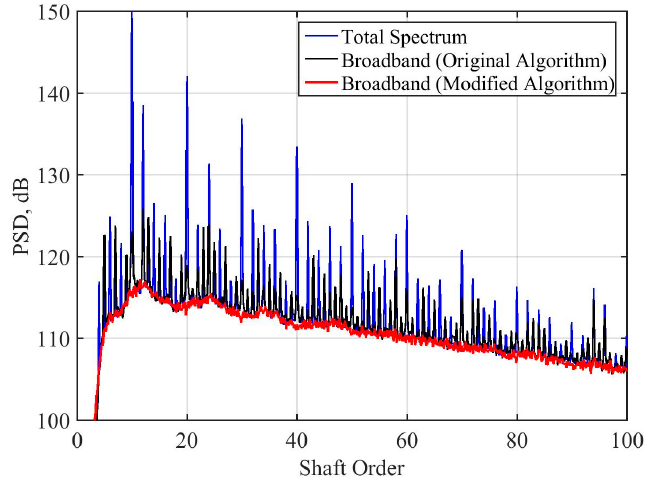
Figure 11. Total and broadband noise spectra from F31/A31 model acoustic data at cruise condition.